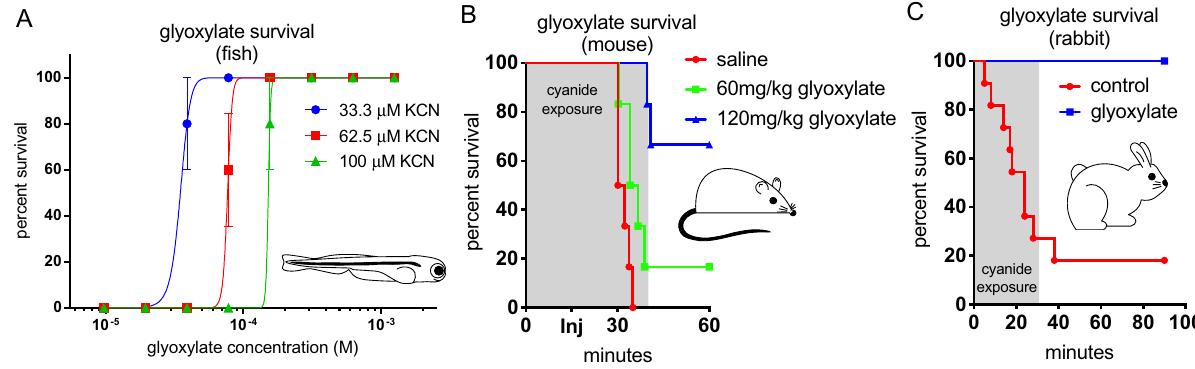
Figure 2. Glyoxylate improves survival rates in vertebrate animal models. ( A ) Percent survival of 5 dpf zebrafish treated with indicated KCN and glyoxylate concentrations, survival assessed 20 h after administration. Fish were arrayed 3 per well. N = 5 wells per glyoxylate concentration in each of the given cyanide conditions. Data are presented as mean ± SEM. ( B ) Mice were exposed for a total of 40 min to 587 ppm HCN gas in a sealed chamber. At 15 min, the mice were removed and received an intramuscular injection of 60 mg/kg glyoxylate (green line), 120 mg/kg glyoxylate (blue line), or saline (red line), and returned to the cyanide chamber for 25 min. N = 6 for all three groups. There was a significant difference in survival between mice injected with 120 mg/kg glyoxylate and mice injected with saline (***p = 0.0005), but not between mice injected with 60 mg/kg glyoxylate and mice injected with saline (p = 0.15). ( C ) An LD80 lethal level dose of i.v. NaCN was administered to rabbits. Upon reaching target systolic BP (50 mm/Hg), 11 control rabbits were injected with 2 mL saline and 10 rabbits were given 2 M glyoxylate while the NaCN infusion continued for 30 min to a total dose of 22 mg. Injection of saline or glyoxylate is designated as time t =